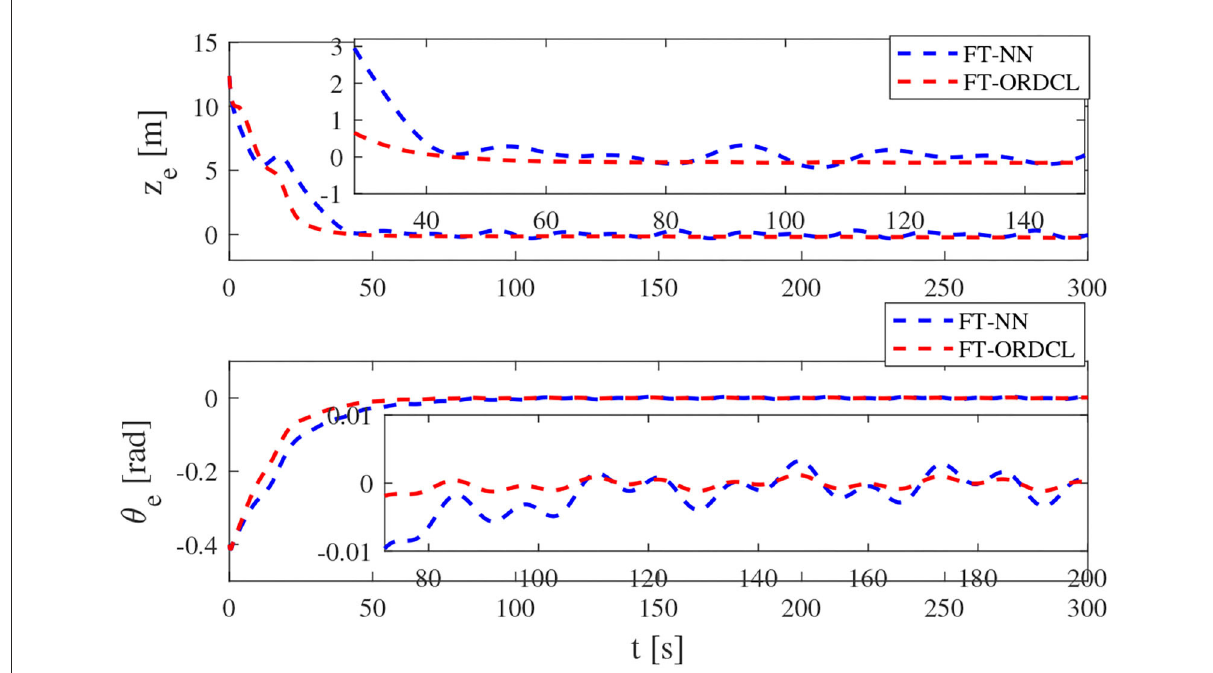
FIGURE2 Tracking position error and yaw angle error in Case 1.